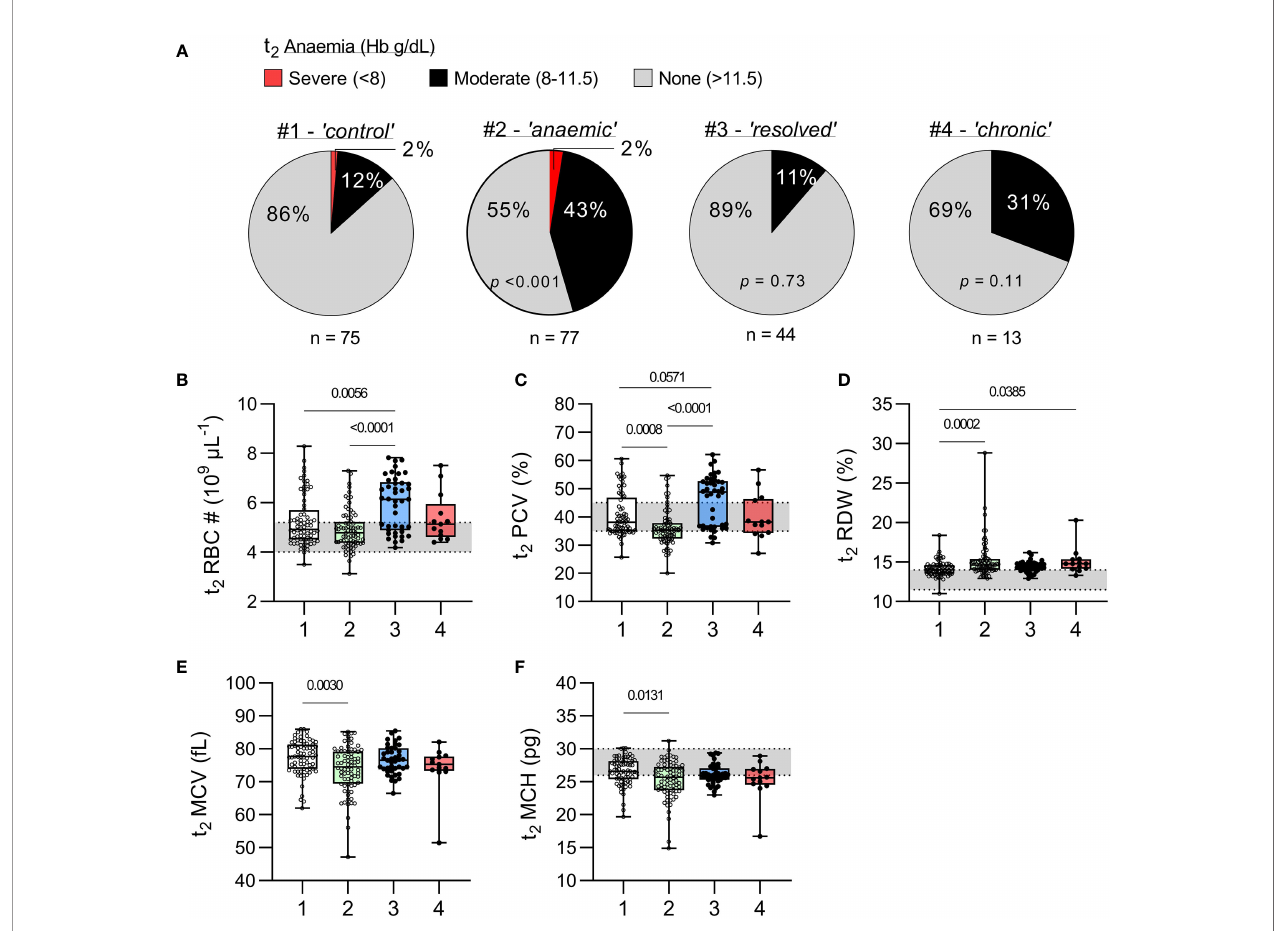
FIGURE 3 | Haematological parameters in uninfected children and children with resolved or persistent P. falciparum infections. (A) Prevalence of anaemia at t 2 , as de fi ned by WHO (18), for each study group and p-value from a chi-square test comparing with the uninfected group ( c 2 ). (B – F) Complete blood counts were performed on venous blood from t 2 for erythrocyte parameters; (B) total red blood cell (RBC) number (#), (C) packed cell volume (PCV) or haematocrit (%), (D) red cell distribution width (RDW, %), (E) mean cell volume (MCV, fL), and (F) mean cell haemoglobin (MCH, pg). Grey shaded areas represent normal paediatric reference ranges (20). Data shown as box plots with min/max whiskers where dots represent each participant. Signi fi cant p values shown, calculated using a Kruskal-Wallis rank sum test followed by a post-hoc Dunn ’ s test with Bonferroni adjustment for multiple comparisons. Group IDs: #1 ‘ Controls ’ , #2 ‘ Anaemic ’ , #3 ‘ Resolved ’ , and #4 ‘ Chronic ’